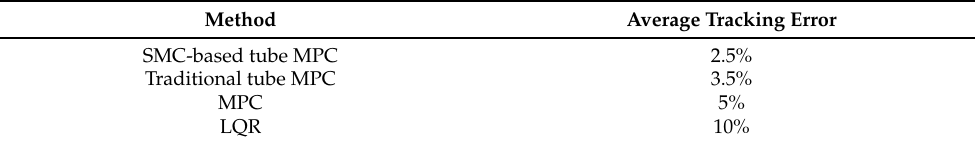
Table 8. Average tracking